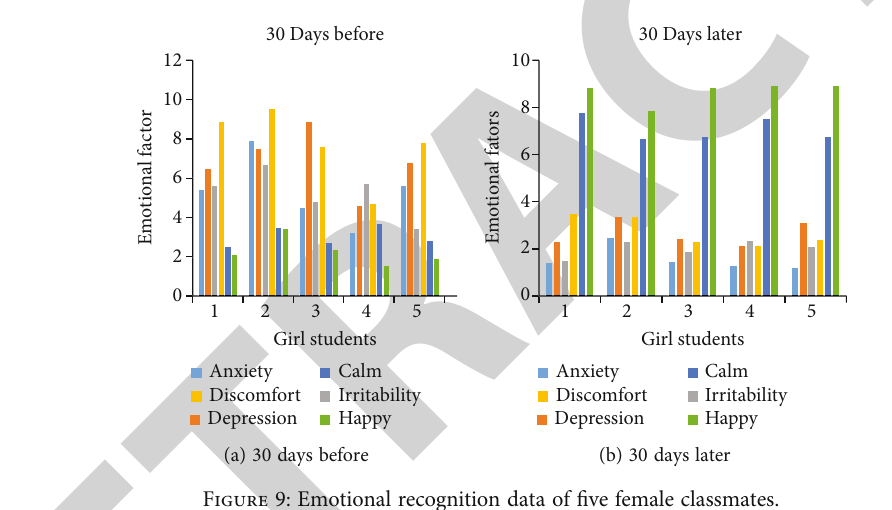
Figure 9: Emotional recognition data of fi ve female